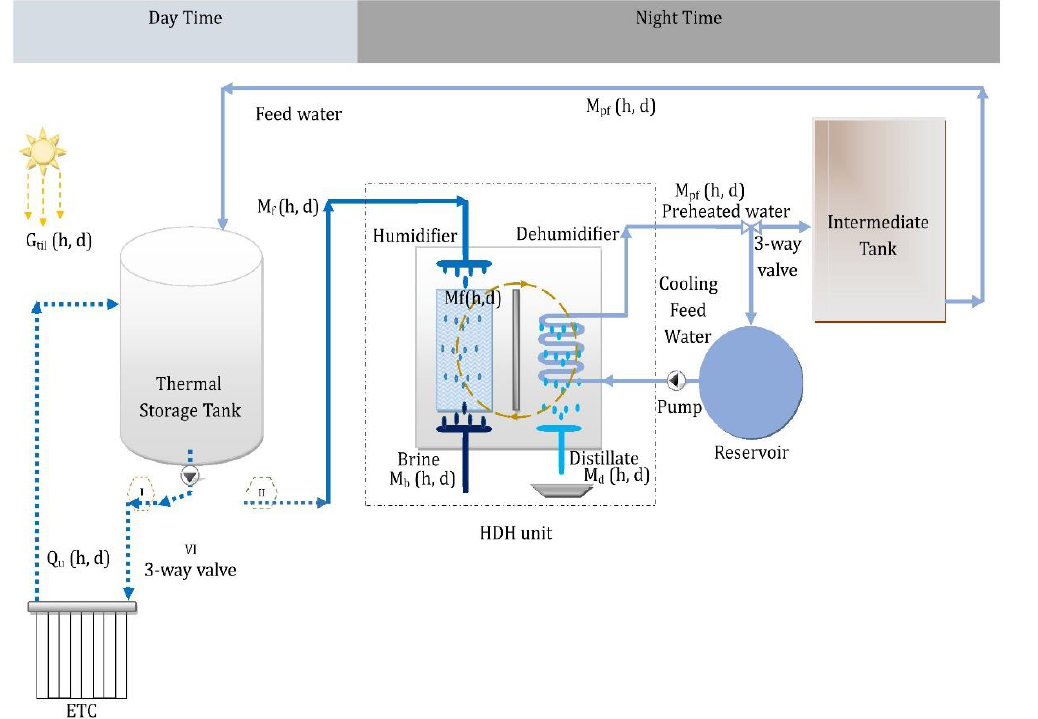
Figure 4. Overall system labeled with key modeling parameters.